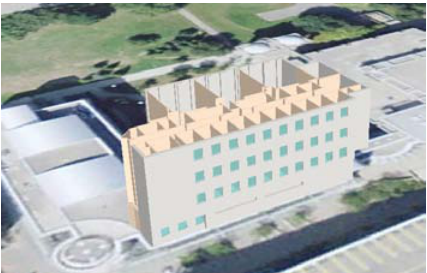
Figure 9. An example of integrated 3D facade and indoor model can be reconstructed based on